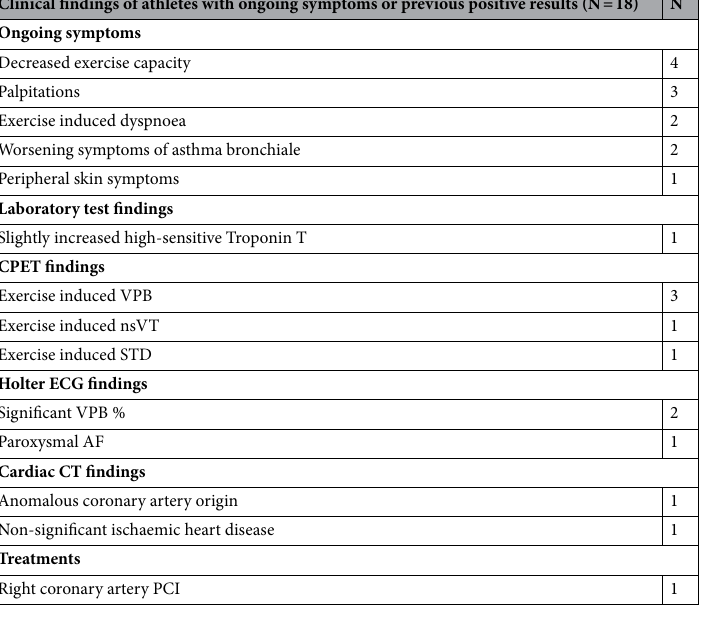
Table 3. Clinical findings of basic, cardiopulmonary exercise testing and further examinations and treatments among 18 athletes with previous positive results or ongoing symptoms during the second visit. CPET cardiopulmonary exercise testing; VPB ventricular premature beats; nsVT non-sustained ventricular tachycardia; STD ST-segment depression; AF atrial fibrillation; CT computer tomography; PCI percutaneous coronary